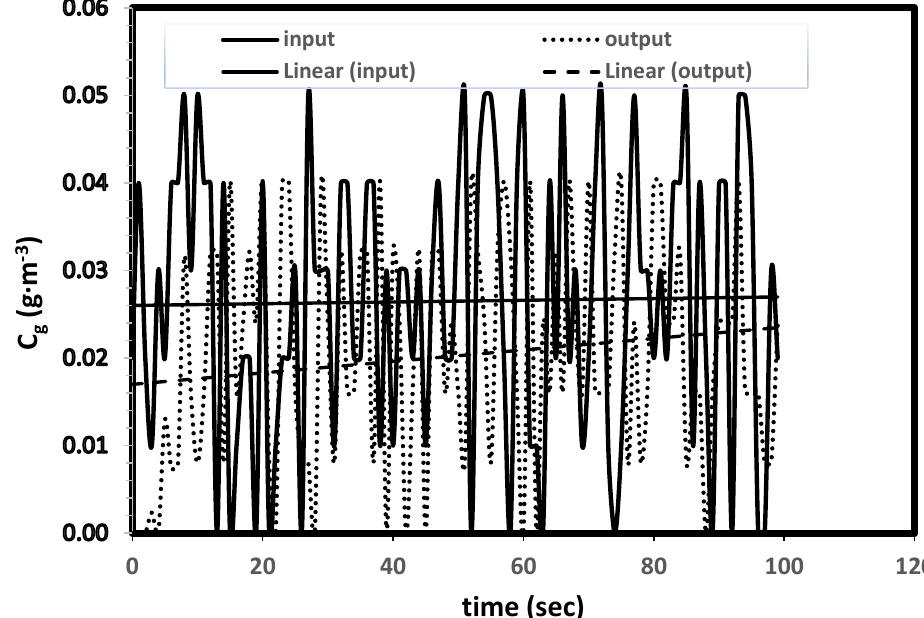
Figure 6. Prediction of biofilter performance with random variations in inlet concentrations.